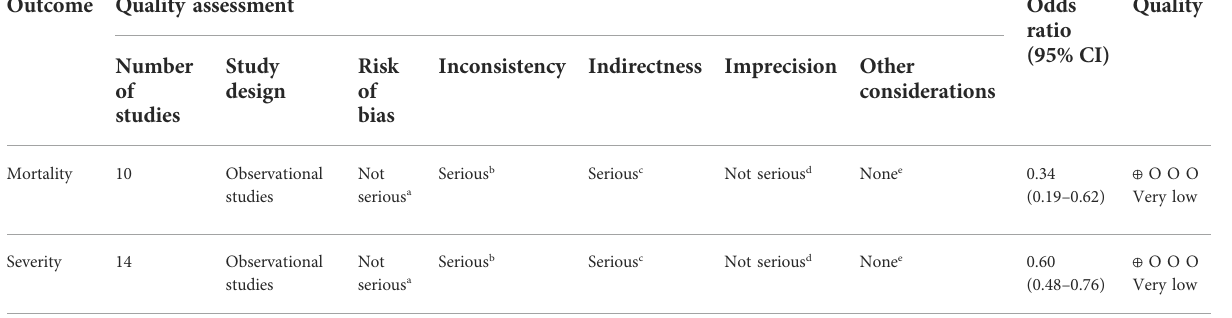
TABLE 3 The quality of evidence of the observational studies included for